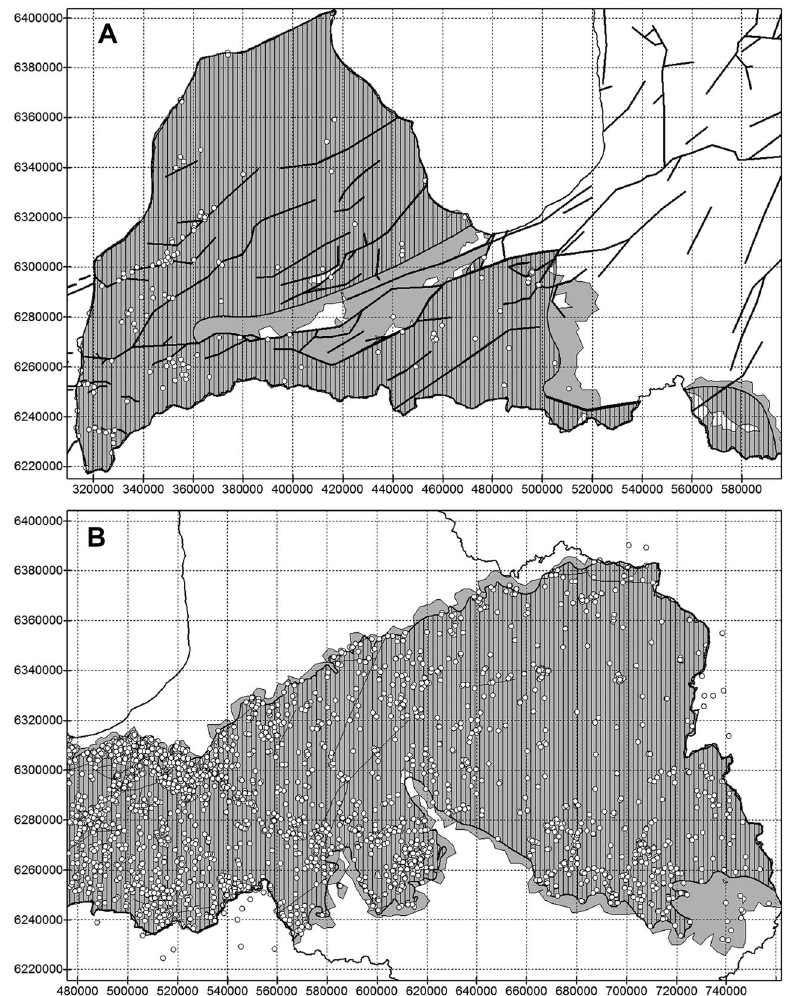
Fig. 7. Modelled distribution of Sld ( A ) and D 3 slp ( B ) layers. Grey area – layer distribution in model structure. Striped area – layer distribution in geological maps. White dots denote